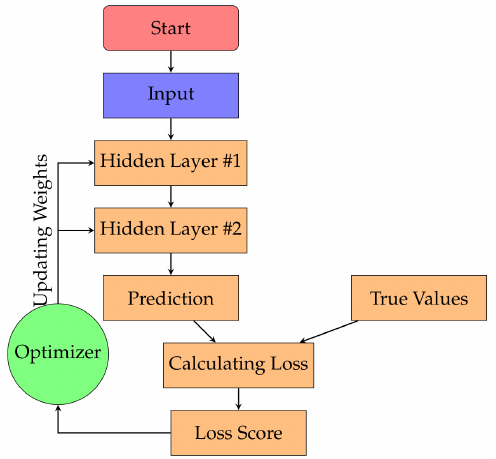
Figure 3. The flowchart of the learning cycle for training the